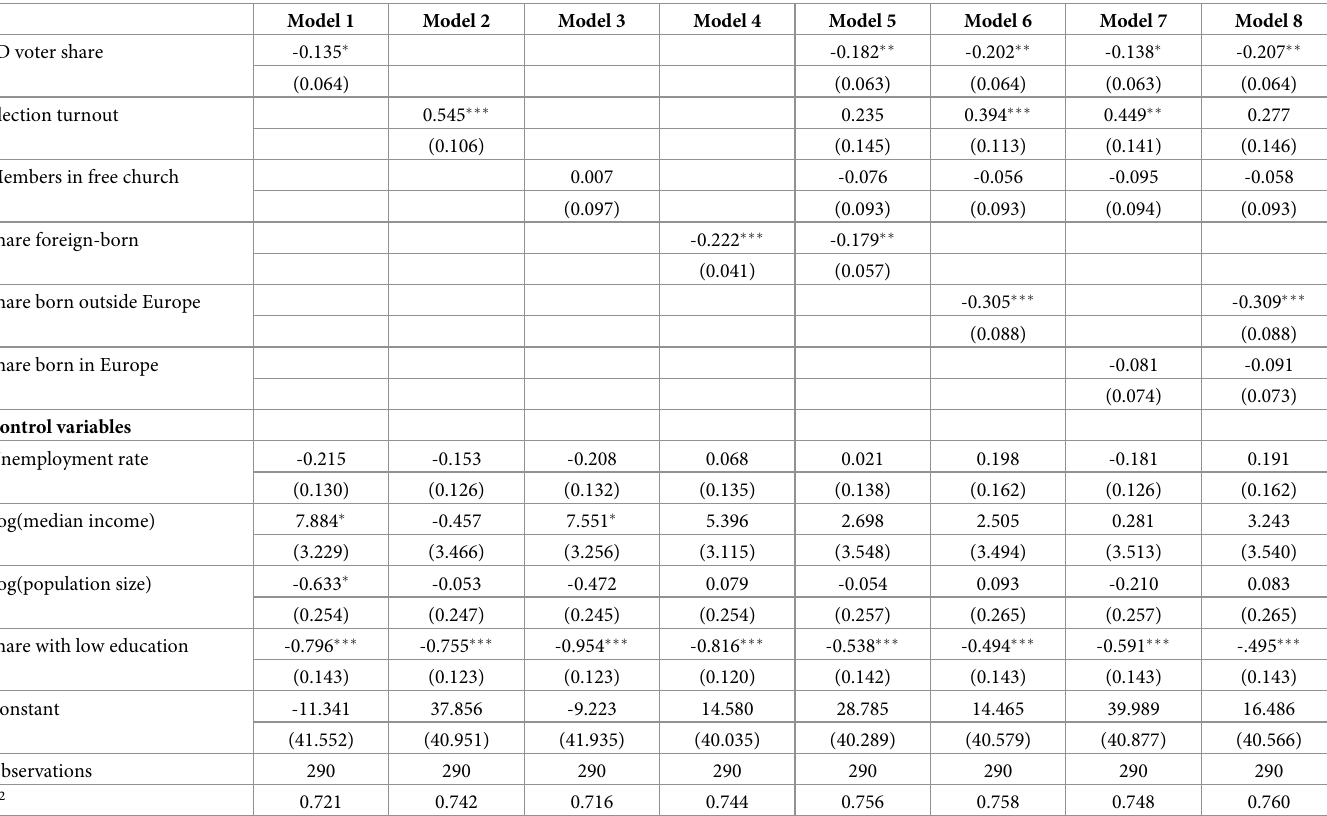
Table 1. The association between various independent variables and vaccine uptake estimated with OLS